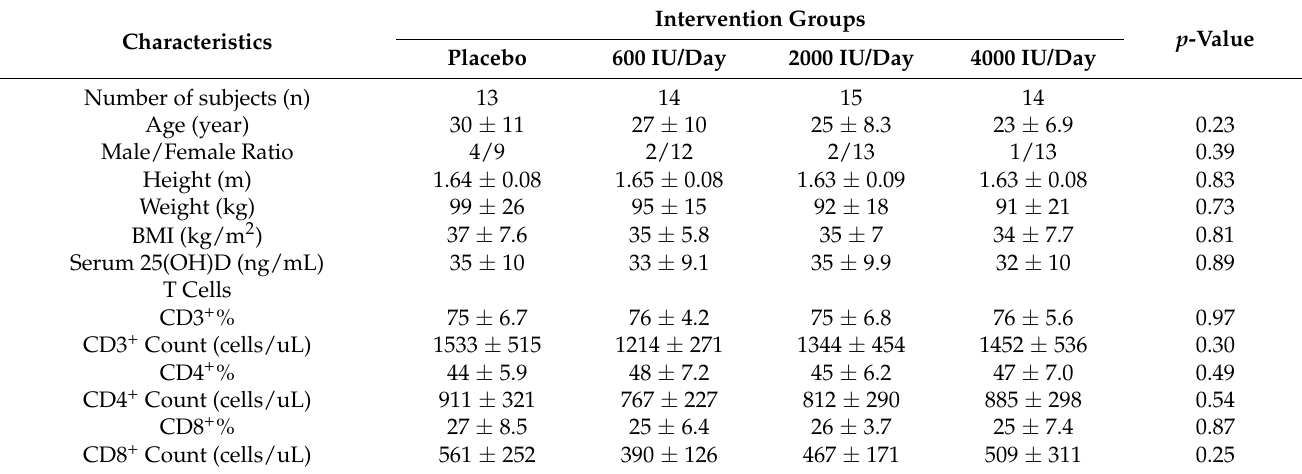
Table 1. Baseline characteristics by intervention groups.